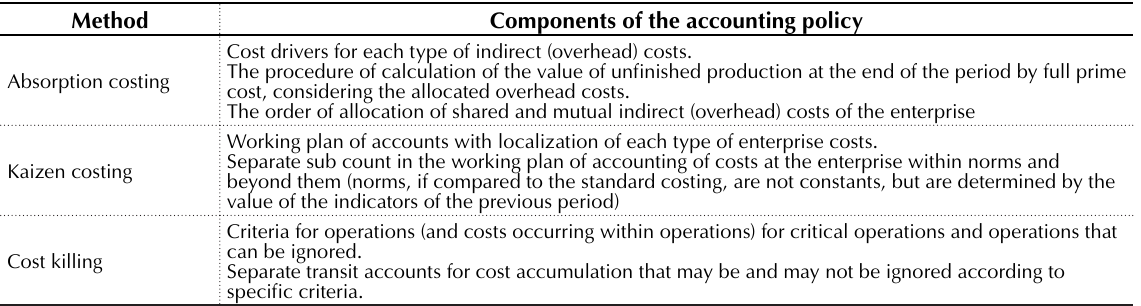
Table 5. Components of the accounting policy at the enterprise required for the use of absorption costing, kaizen costing, and cost killing in operational enterprise costs management